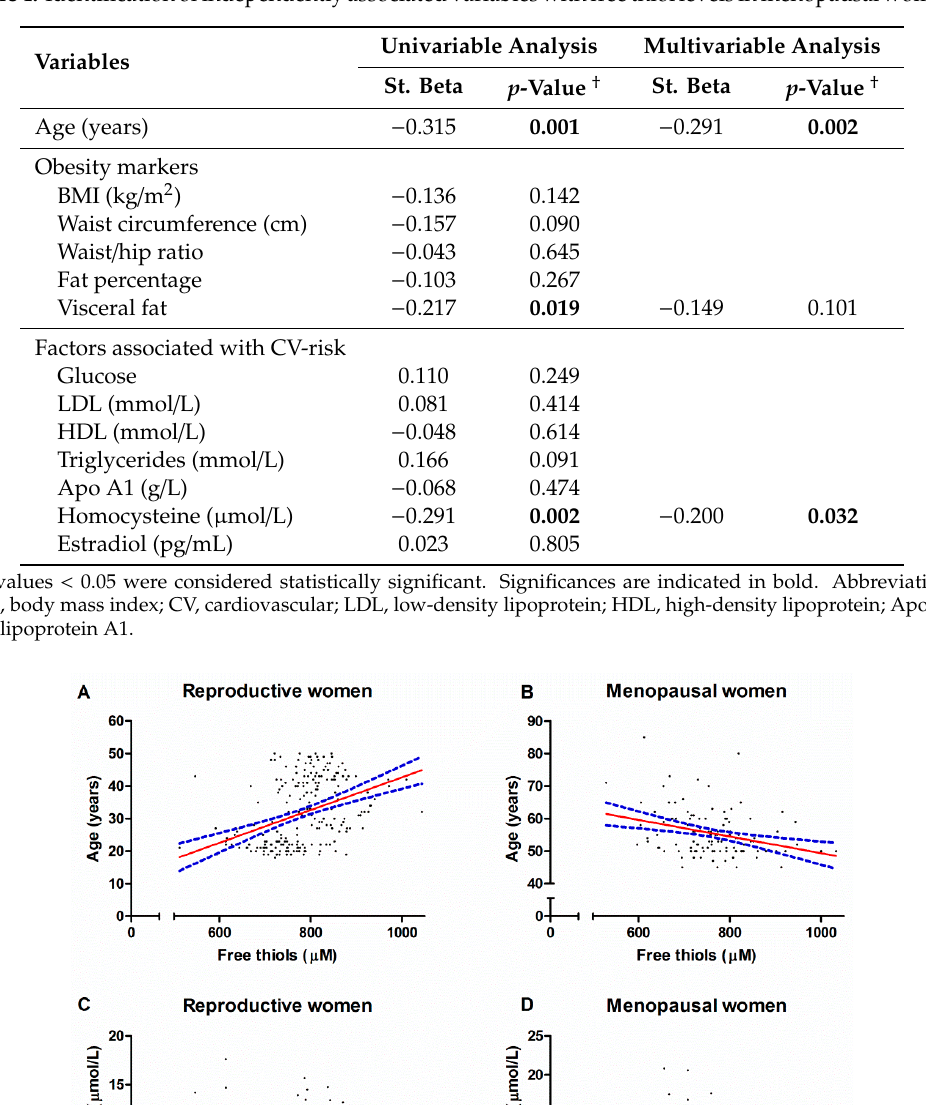
Table 4. Identification of independently associated variables with free thiol levels in menopausal women. Table4. Identificationofindependentlyassociatedvariableswithfreethiollevelsinmenopausalwomen.